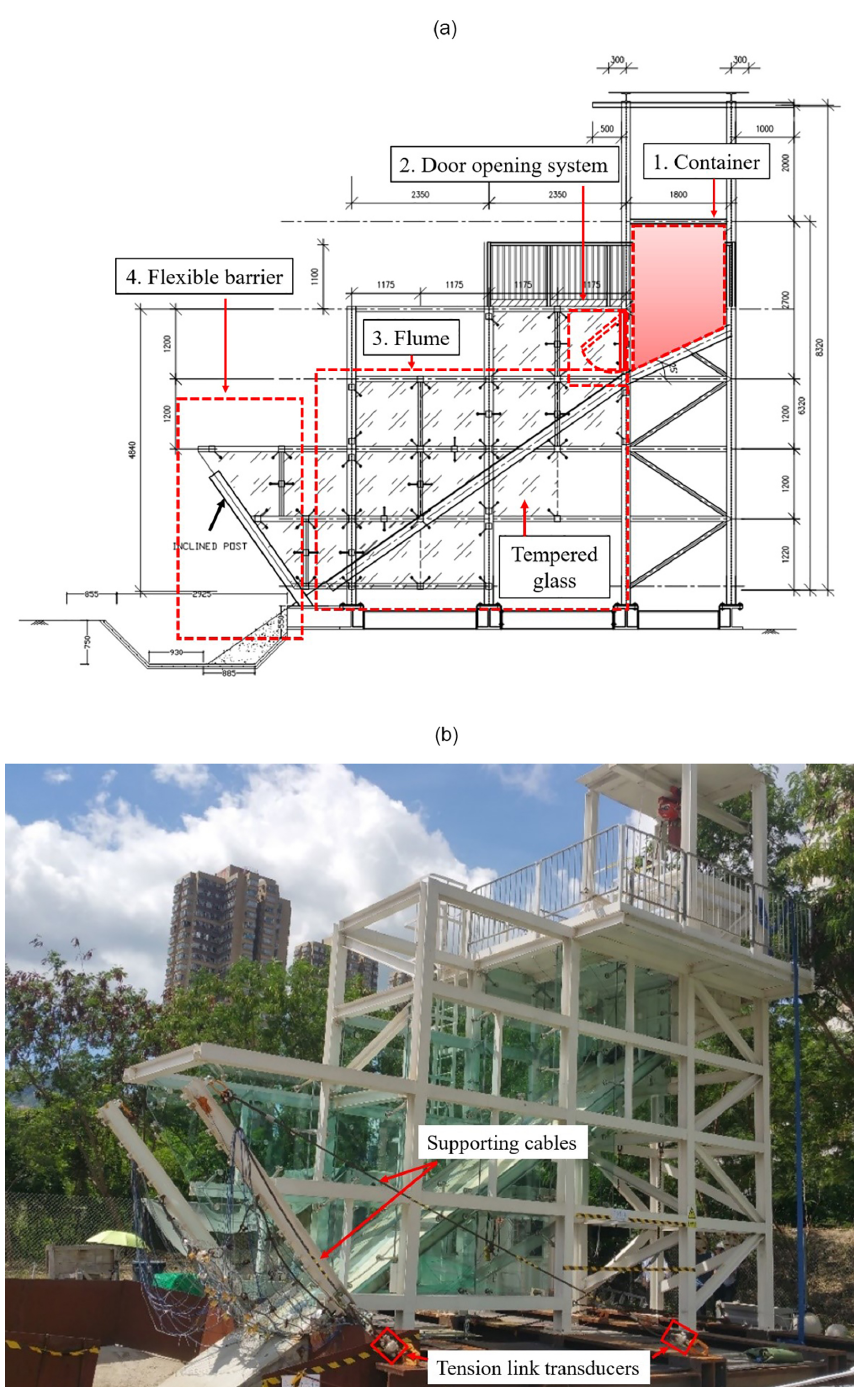
Figure 1. (a) Side view of a large-scale physical model design (unit: mm) and (b) photograph of the physical modelling facility constructed at a site in Hong